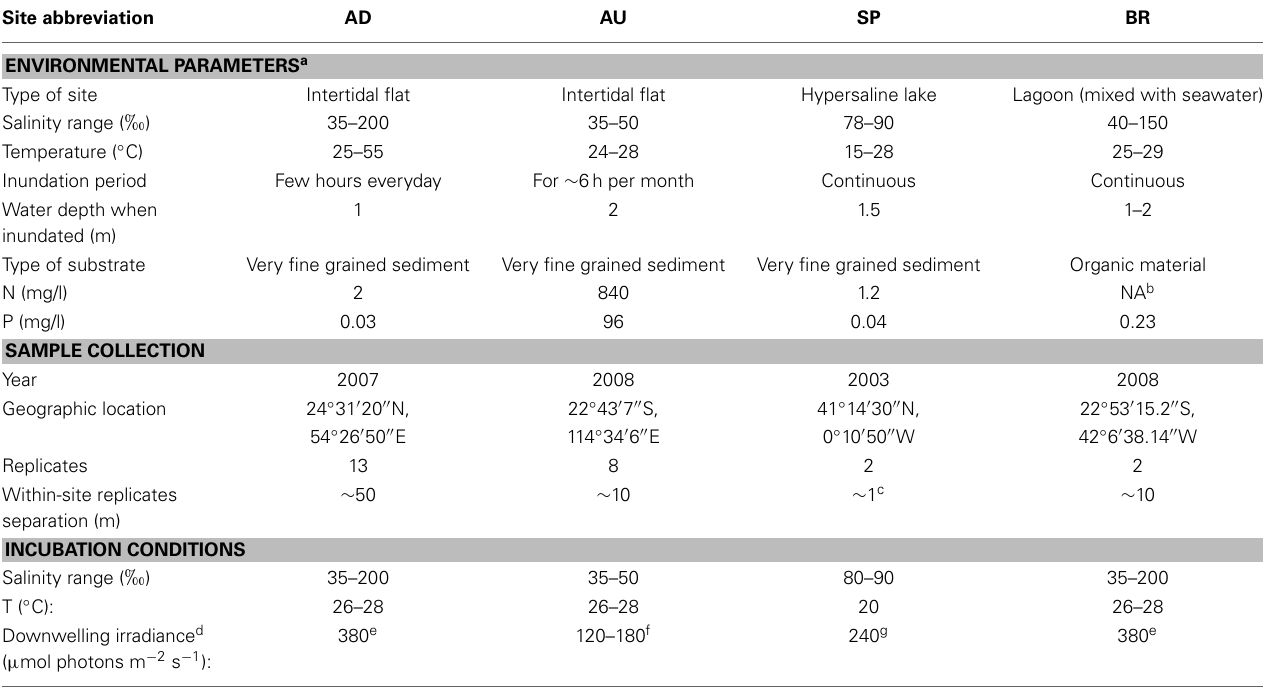
Table 1 | Characteristics of the sampling sites, collection details, and incubation conditions for the studied microbial